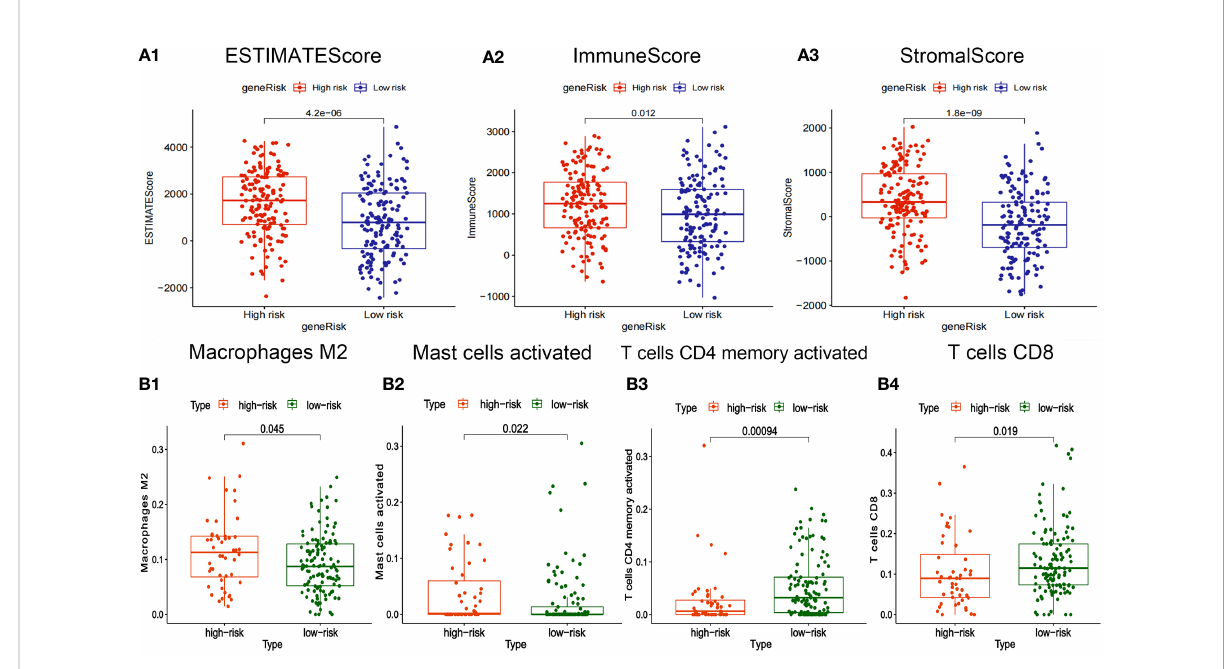
FIGURE 6 Correlation between risk-score of ceRNA related prognosis model and immune microenvironment. (A1-3) Correlation analysis between risk score and ImmuneScore/StromalScore of gastric cancer. (B1-4) Correlation analysis between risk-score and abundance of invasive immune cells in gastric